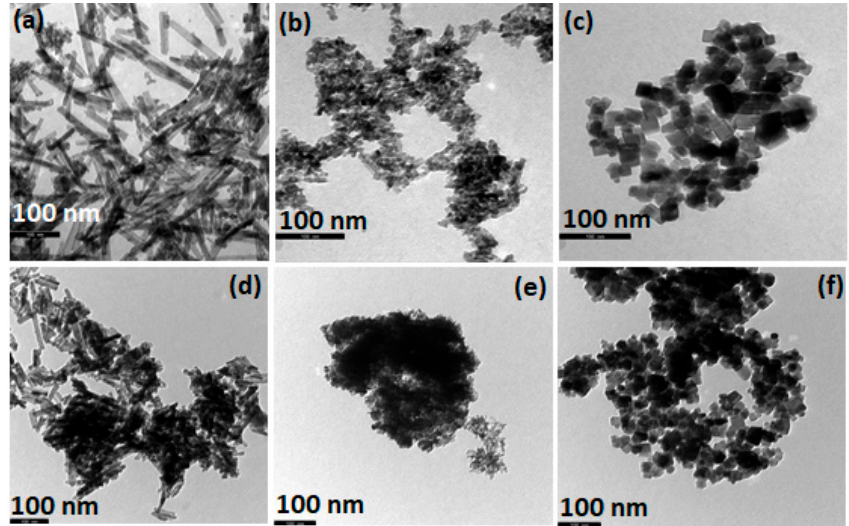
Figure 3. The transmission electron microscopy images of CeO 2 ( a – c ) and Co/CeO 2 ( d – f ) samples: ( a ) CeO 2 -NR, ( b ) CeO 2 -NP, ( c ) CeO 2 -NC, ( d ) Co/CeO 2 -NR, ( e ) Co/CeO 2 -NP and ( f ) Co/CeO 2 -NC.